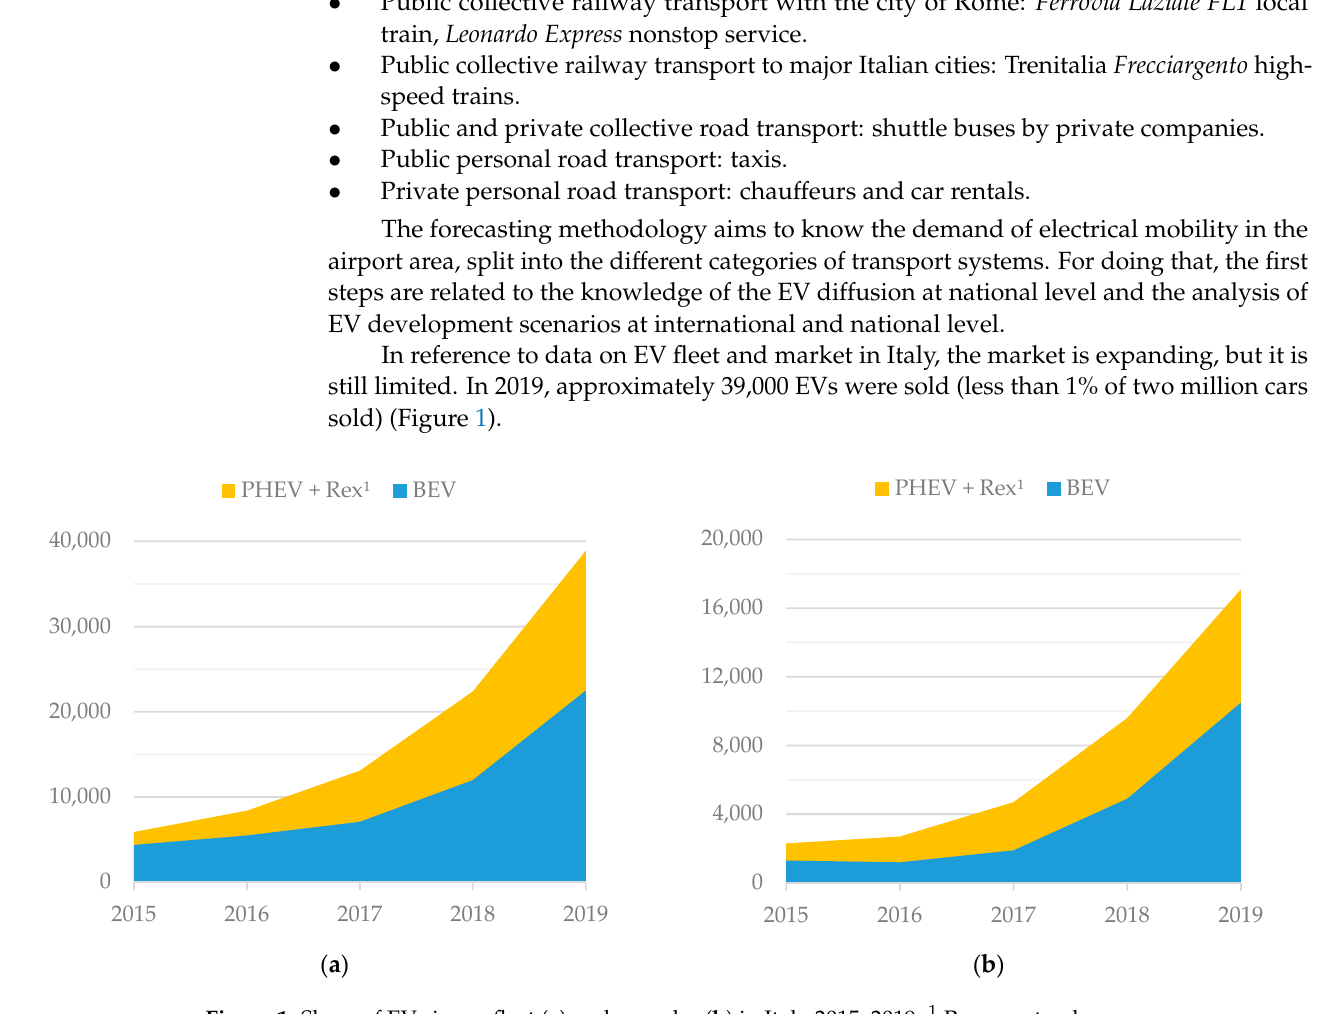
Figure 1. Share of EVs in car fleet ( a ) and car sales ( b ) in Italy 2015–2019. 1 Range extender. The analysis of EV development scenarios at international and national level has been referred to from different sources, and the results of the wide analysis and comparison is reported in the next section. From these scenarios, two reference scenarios have been defined at national level, as a starting point of the forecasting methodology proposed in Section 4. Estimated average BEV and PHEV penetration index on car sales, for 2025 and 2030, at world level, is reported in Figure 2.